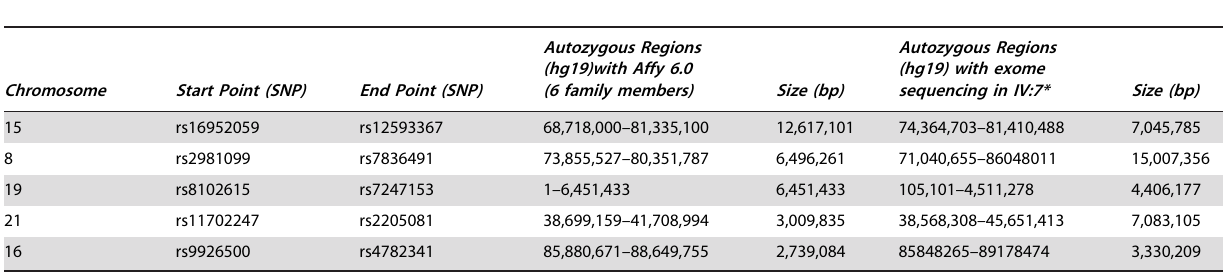
Table 1. Five autozygous regions detected with Affymetrix 6.0 arrays in the family.